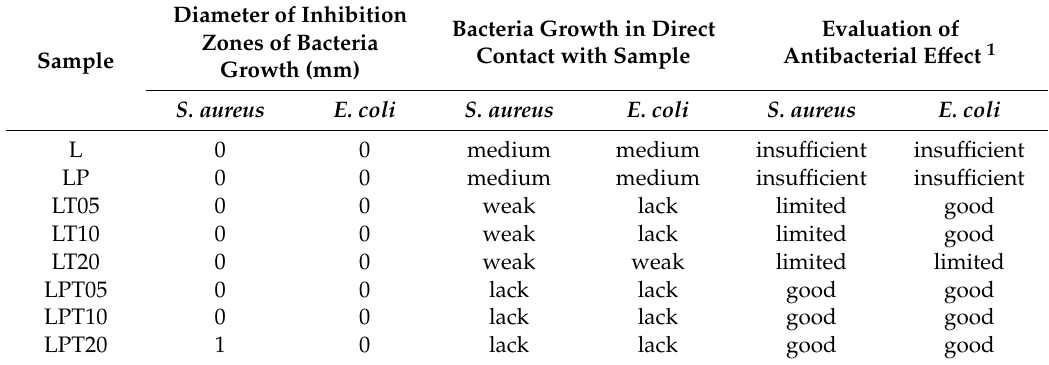
Table 3. Results of antibacterial activity of the examined PLA-based